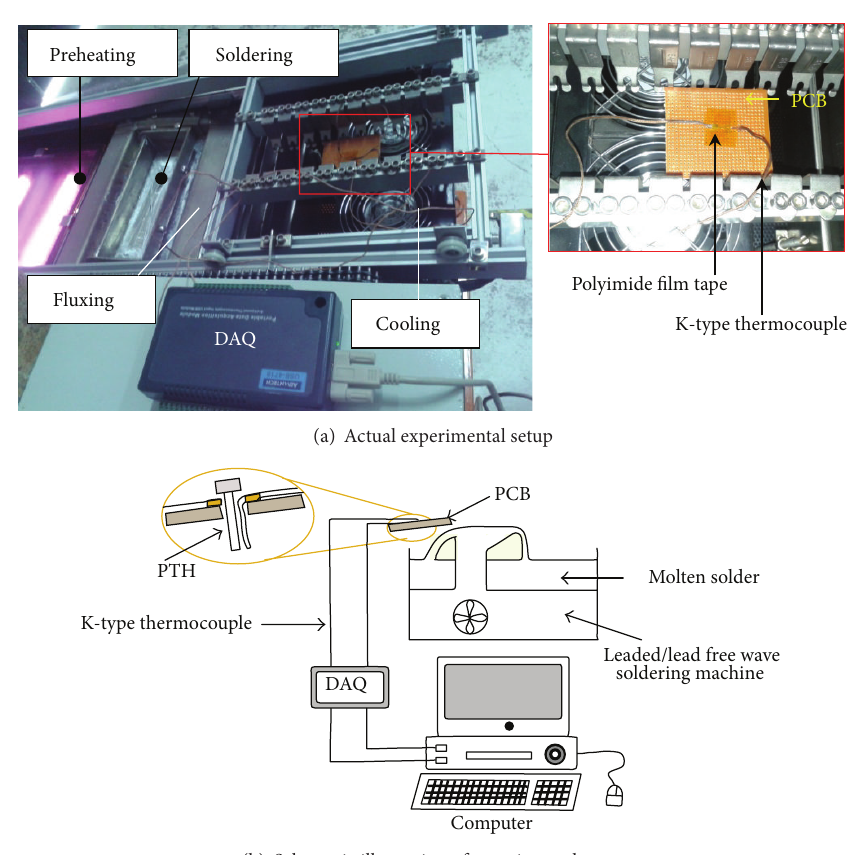
Figure 6: Experimental setup of wave soldering